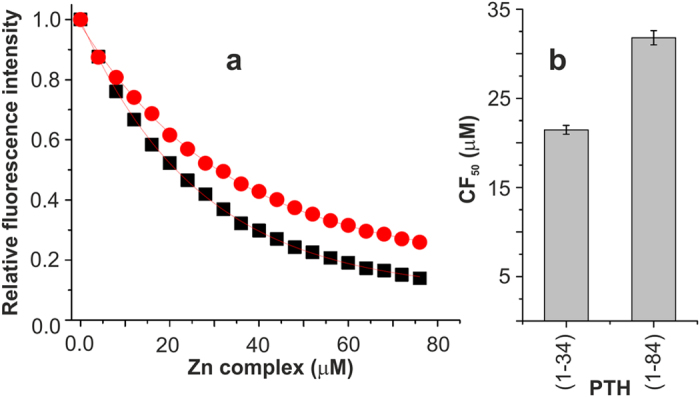
Fluorescence quenching of the PTH peptide hormone by the Zn complex.(a) Relative fluorescence intensity plot and best fit (red lines) according to equation for ■ – PTH(1–34) and  – PTH(1–84). (b) CF50 in μM (concentrations of the Zn complex required for 50% fluorescence quenching) plot.